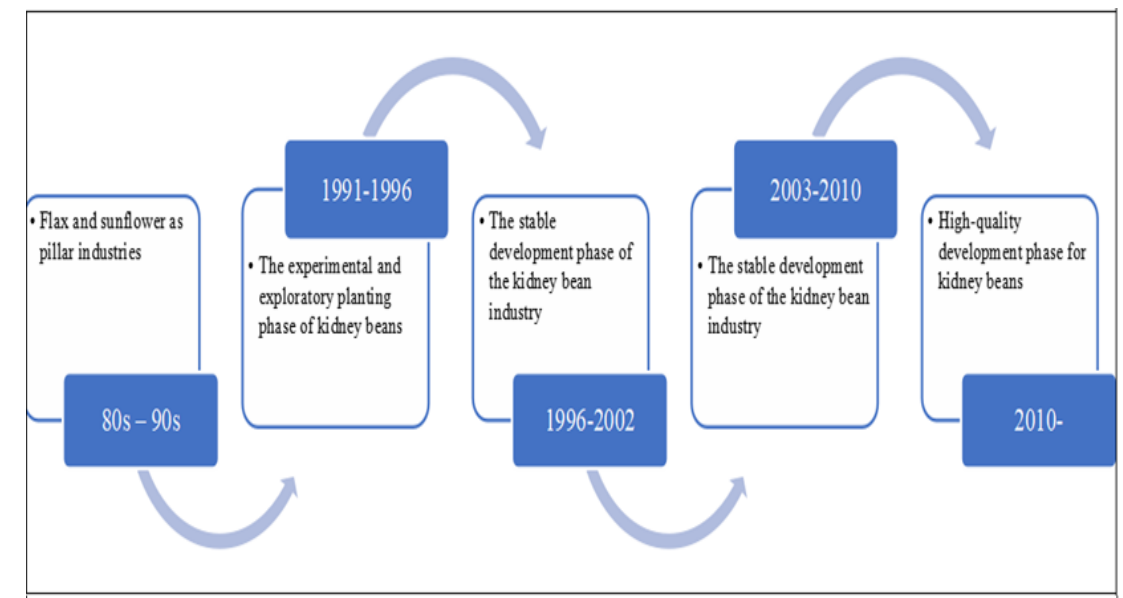
Figure 1. Five different stages of kidney bean development in KL County.